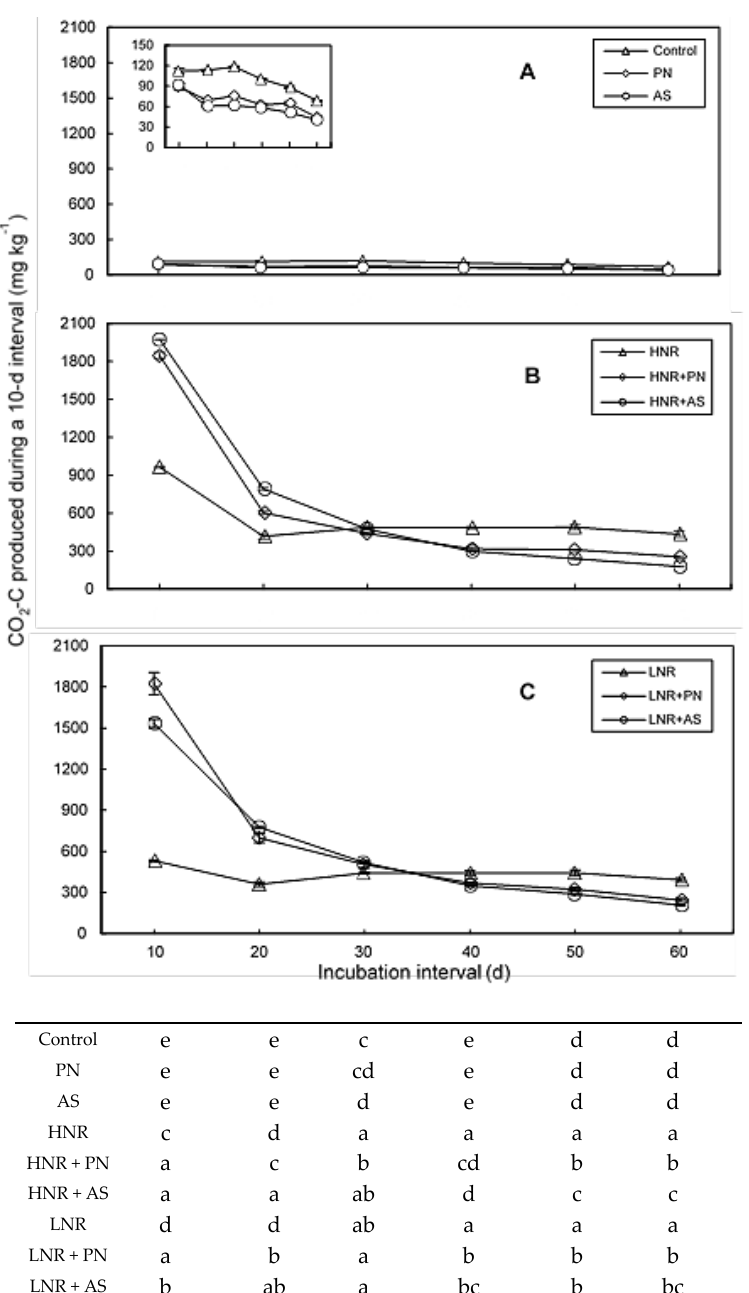
Figure 2. Total quantity of CO 2 -C produced by soil in 10 d intervals during a 60 d aerobic incubation involving the following nine treatments: ( A ) unamended control, potassium nitrate (PN), ammonium sulfate (AS); ( B ) high N residue (HNR) with or without PN (HNR + PN) or AS (HNR + AS); and ( C ) low N residue (LNR) with or without PN (LNR + PN) or AS (LNR + AS). Data shown as a mean from triplicate incubations with standard error bars and a table for mean comparisons. Within a given incubation interval, treatments followed by the same letter do not differ significantly at p < 0.05. When compared at a smaller scale ( A ), CO 2 -C was significantly greater ( p < 0.01) for the control than for the PN or AS treatment.